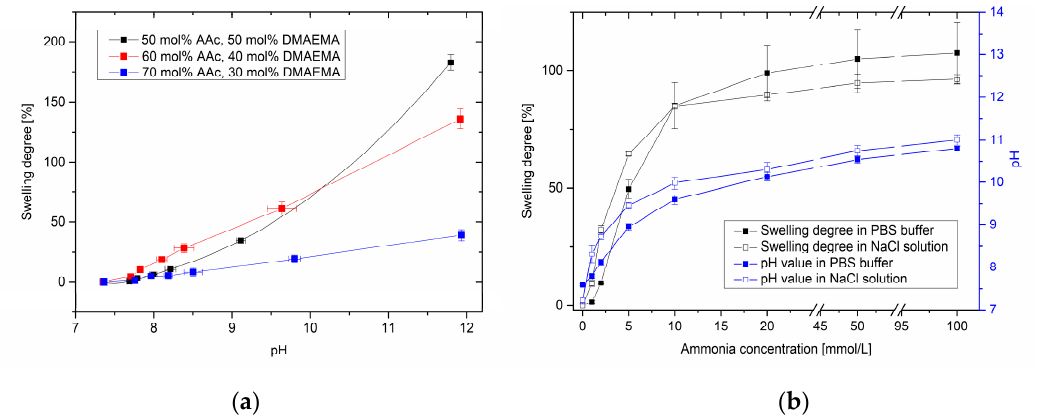
Figure 1. Results of the swelling studies: ( a ) Swelling degree of poly (AAc- co -DMAEMA) hydrogels versus pH value for different monomer contents in PBS buffer; ( b ) Swelling behavior of poly(AAc- co - DMAEMA) (60% AAc, 40% DMAEMA) hydrogels and resulting pH value for different ammonia concentrations in PBS buffer and isotonic saline solutions